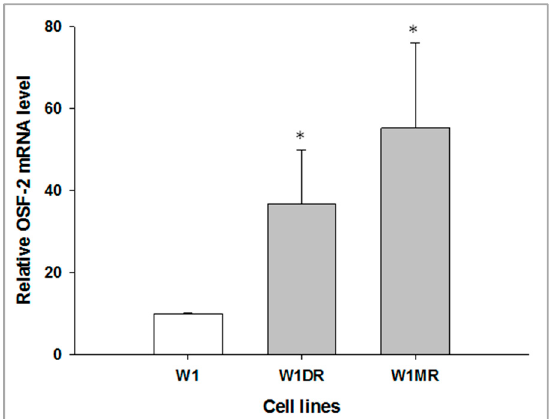
Figure 2. Expression analysis (Q-PCR) of the OSF-2 transcript. The figure presents the relative OSF-2 gene expression in DOX- and MTX-resistant cell lines (grey bars) with respect to the W1 drug-sensitive cell line (white bar), which was assigned a value of 1. The values were considered significant at * p < 0.05.